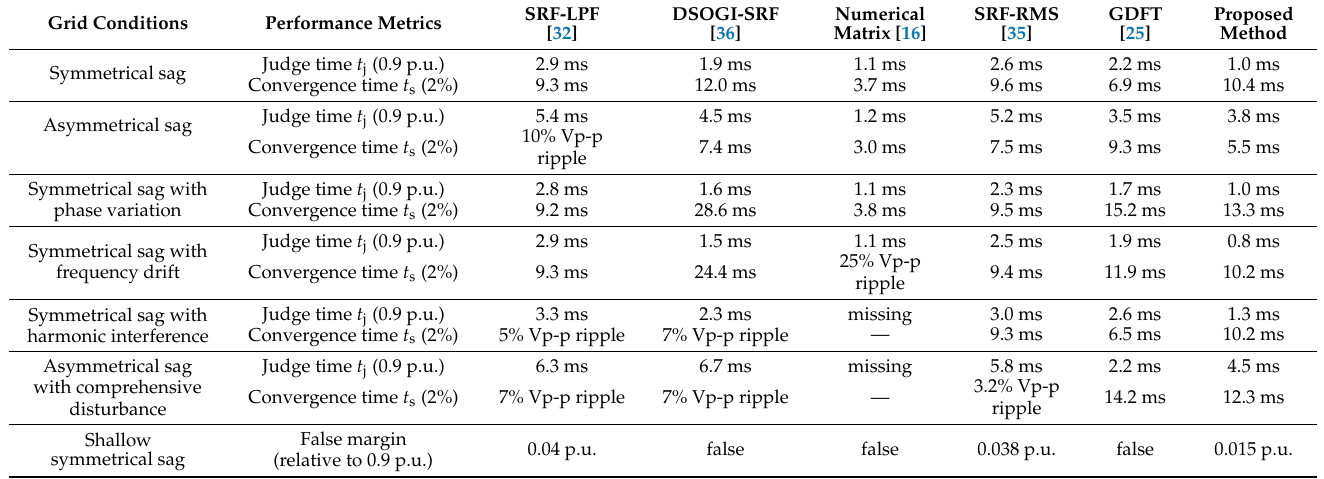
Table 2. The performance of the different voltage detection